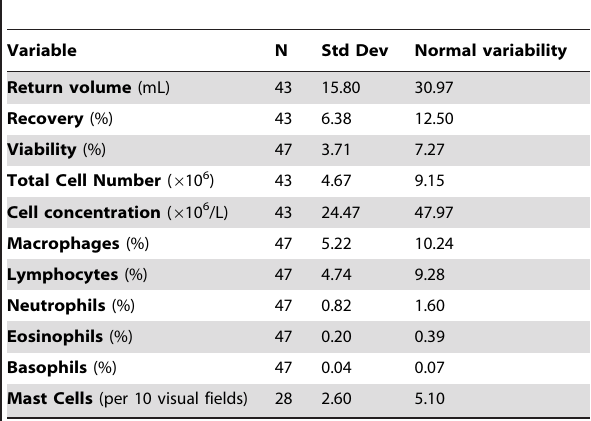
Table 4. Comparison of bronchoalveolar lavage fluid findings between healthy never-smoking females and males.